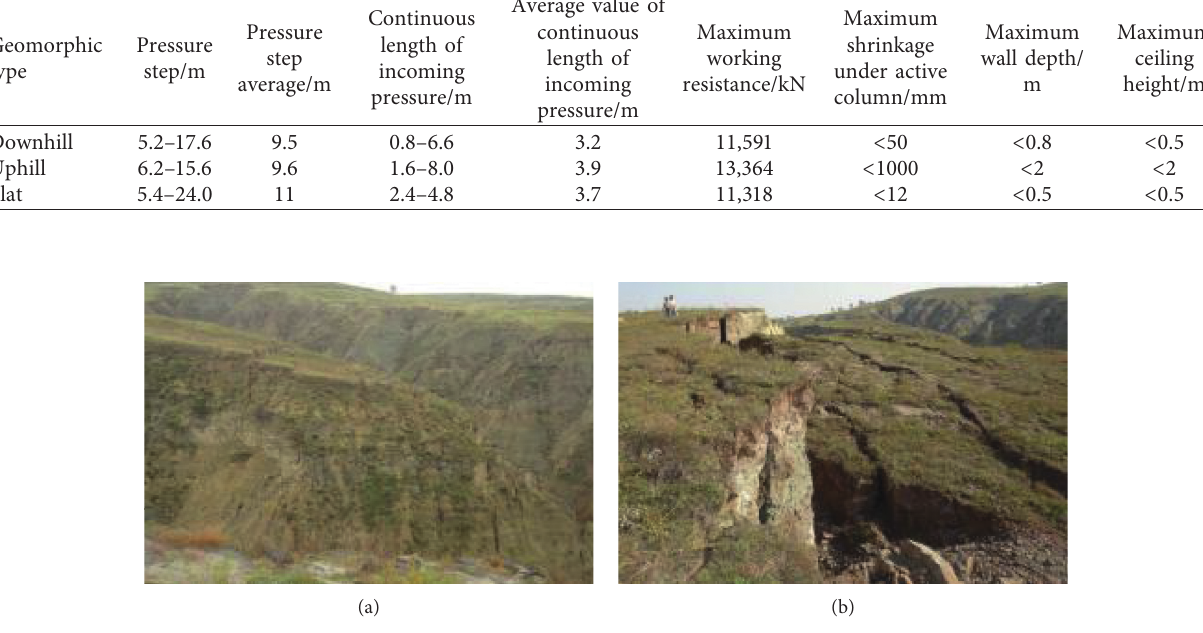
Figure 2: Field observations. (a) The first dynamic strata pressure. (b) The second dynamic strata pressure.